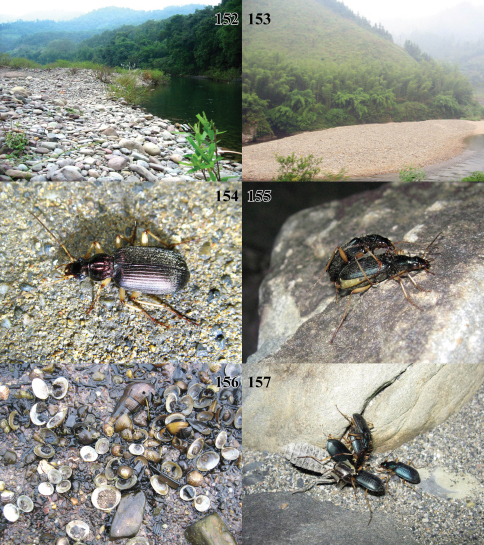
Photographs of habitats for Chlaenius (Lithochlaenius) spp. 152 Chlaenius rambouseki Lutshnik, Baisha county, Hainan Island, China153 Chlaenius rambouseki Lutshnik, Yuanbaoshan, Guangxi, China154 Chlaenius rambouseki Lutshnik adult walking on concrete wharf of Ussri river at night155 Chlaenius agiloides Jedlička adults mating at night156 Assorted molluscs, show one food of Chlaenius rambouseki Lutshnik from Hainan Island157 Adults of Chlaenius agiloides Jedlička preying on dragonfly nymph at night.